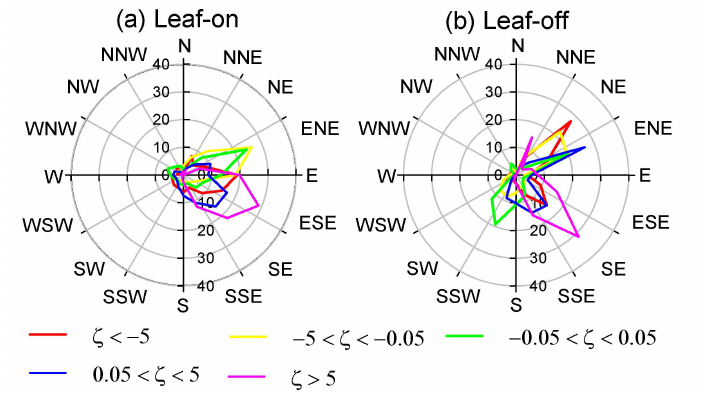
Figure 14. Relative frequency distributions of wind direction at the 2 m for five stability regimes during the leaf-on ( a ) and leaf-off ( b ) seasons of